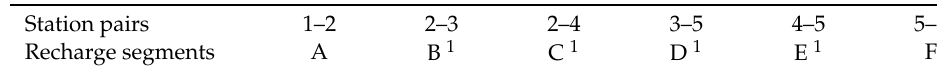
Table 2. Station pairs and associated network segments.